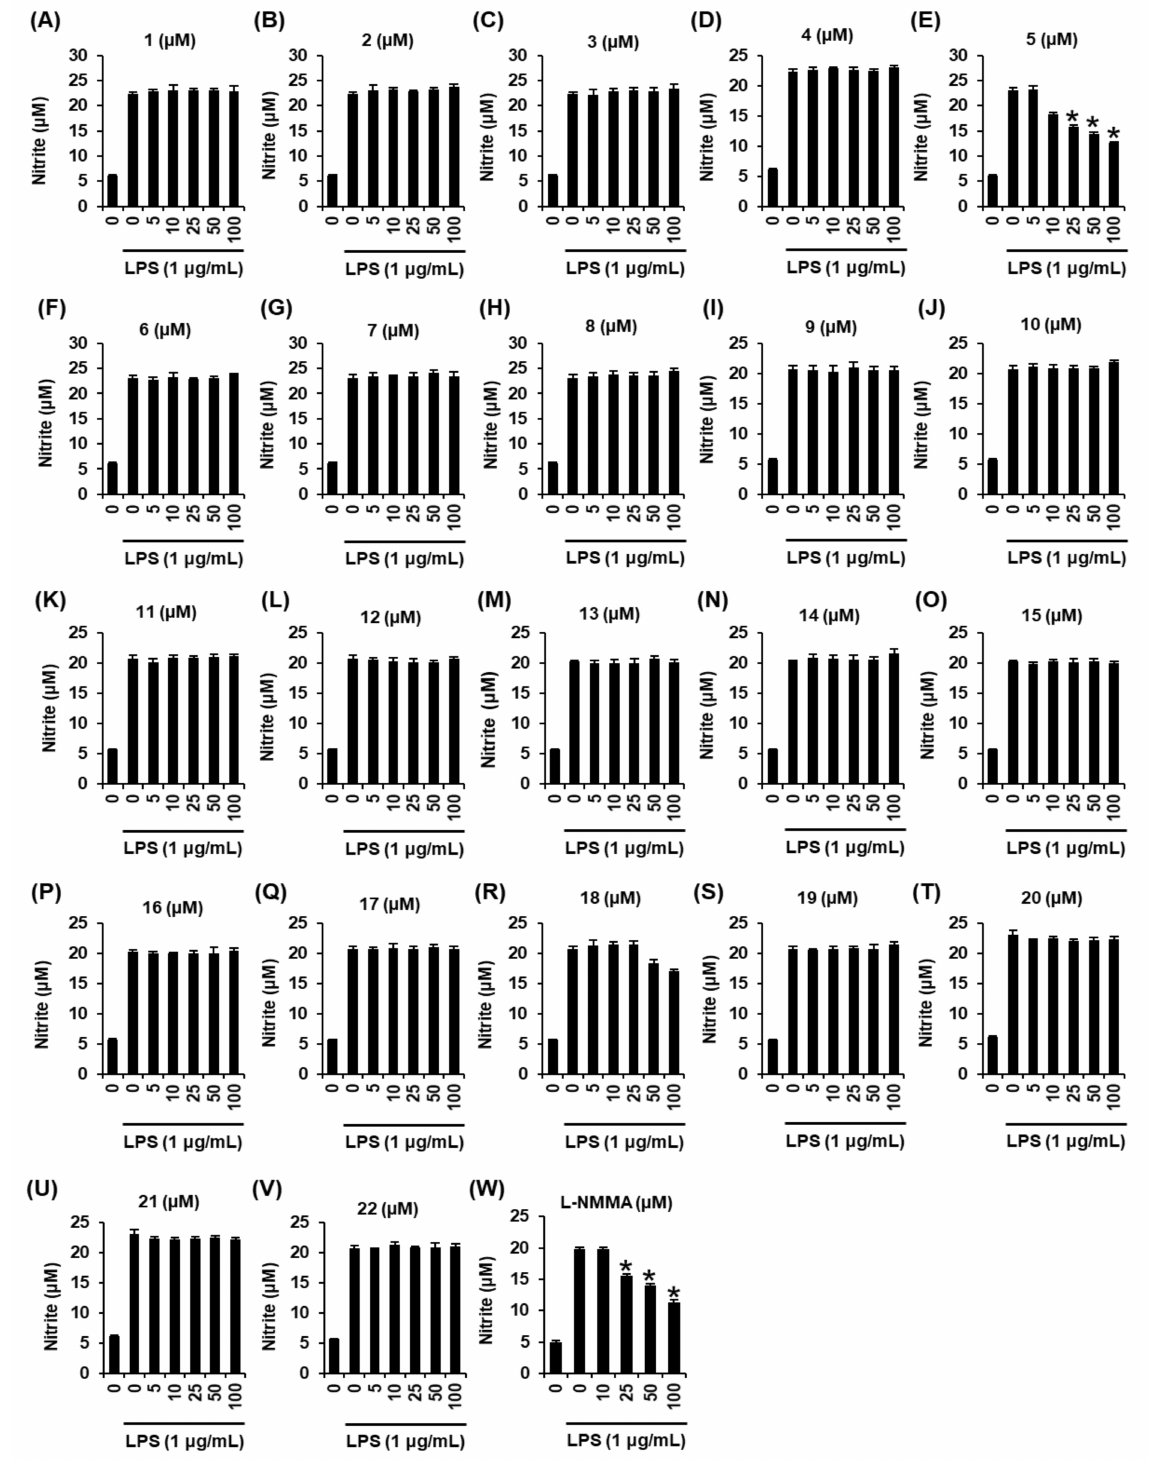
Figure 3. Effects of compounds 1 – 22 isolated from M. alba fruits and N G -methyl-L-arginine acetate salt (L-NMMA) on the nitric oxide (NO) production in RAW 264.7 mouse macrophages treated with lipopolysaccharide (LPS). ( A – W ) The effects of compounds 1 – 22 and the nitric oxide (NO) synthase inhibitor L-NMMA in RAW 264.7 mouse macrophages treated with LPS were investigated (mean ± SD, * p < 0.05 compared to group treated with 1 µ g/mL LPS